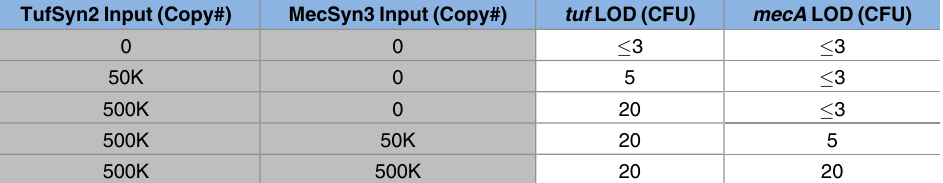
Table 3. Effect of multiple synthetic templates as suppressors on assay limit of detection.